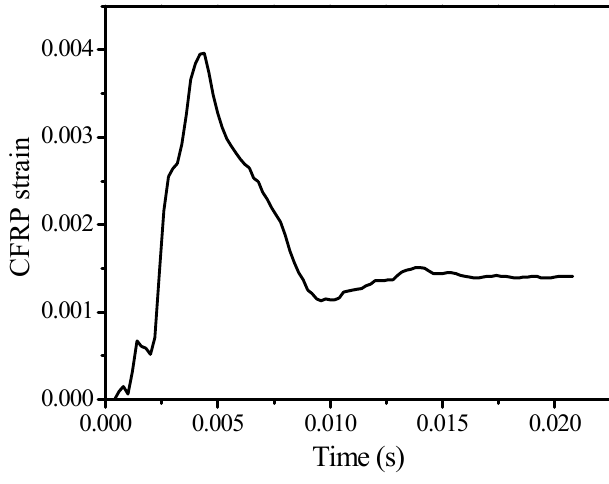
Figure 8. Strain–time history of CFRP.